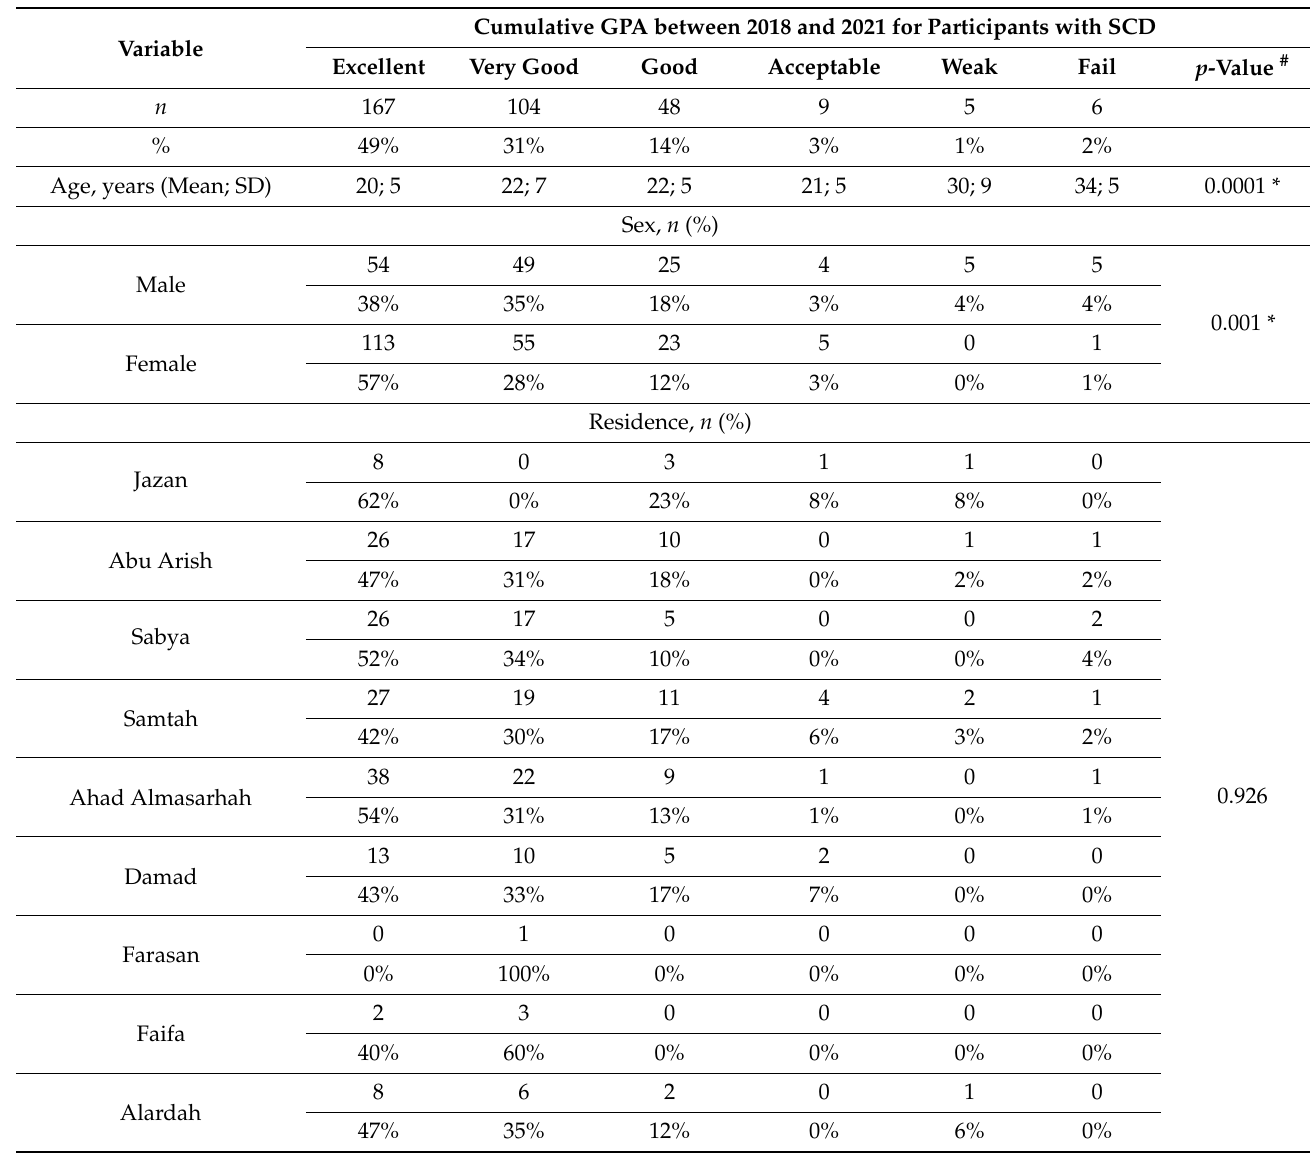
Table 3. Cumulative GPA between 2018 and 2021 for participants with SCD and associated